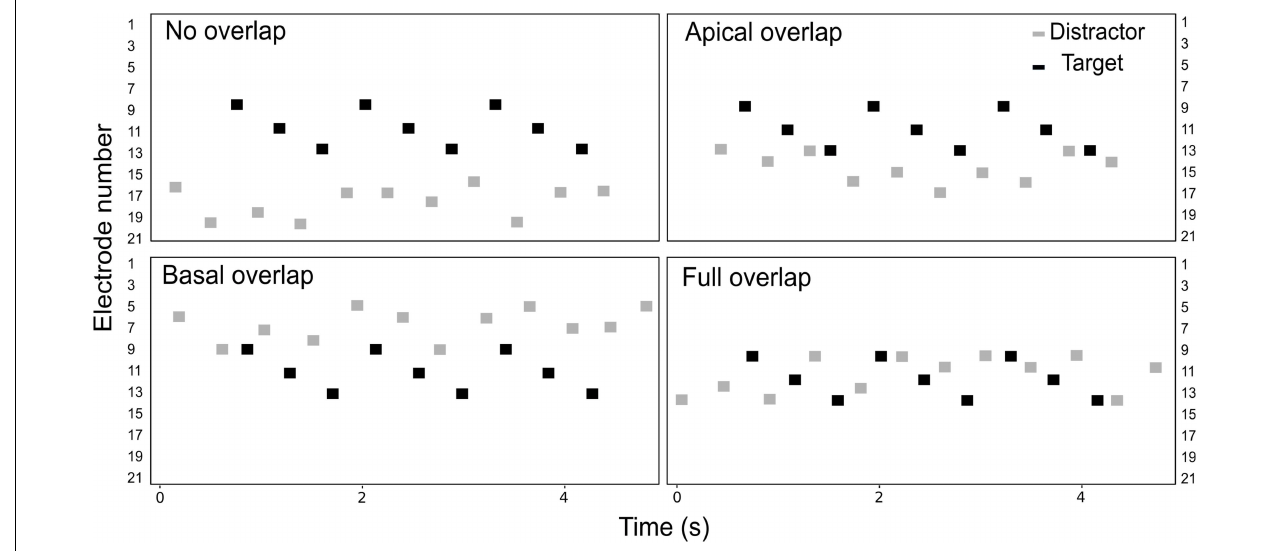
FIGURE 2 | Schematic representation of the electrodogram for each of the four electrode separation conditions. Black and gray markers represent the target and the distractor sounds, respectively. On each trial, the distractor stream started before the target stream and ended after the target stream, with a random number of one to four